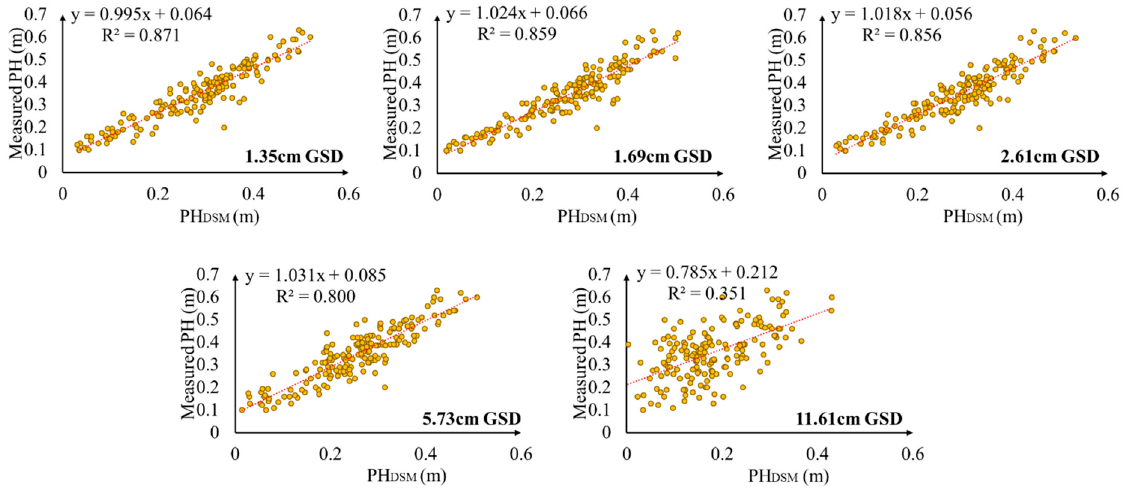
Figure 8. Relationships between ground-measured PH and DSM-derived PH (PH DSM ) at different GSDs.